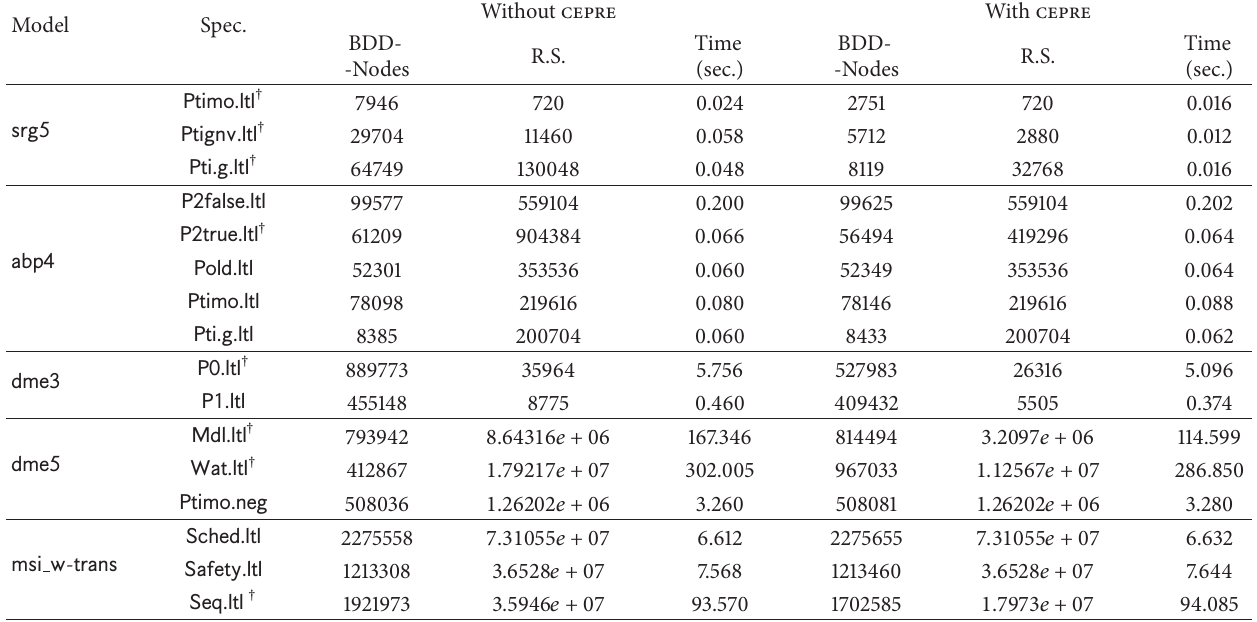
Table 9: Comparative results of BDD-based MC with/without cepre.